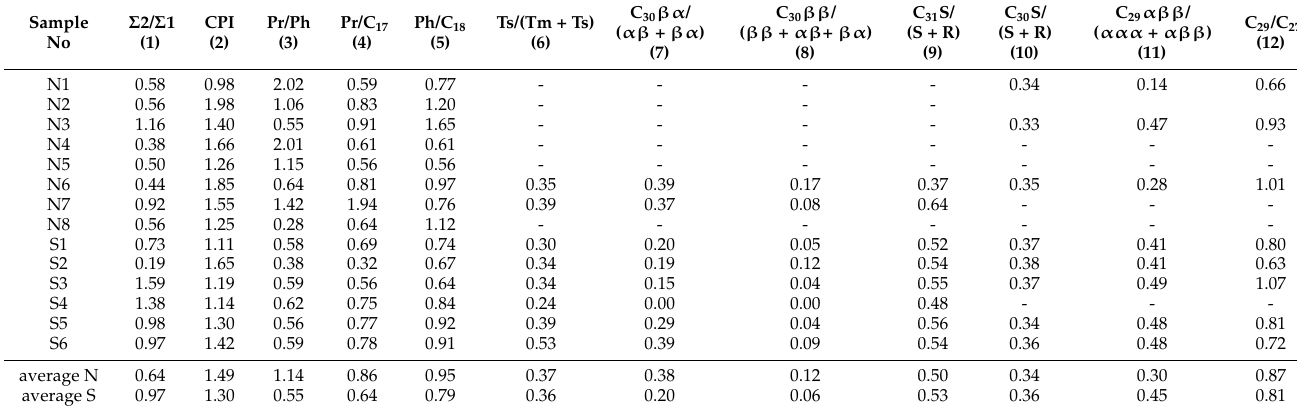
Table 4. Extraction yields and biomarker ratios indicative of maturity and biogenic